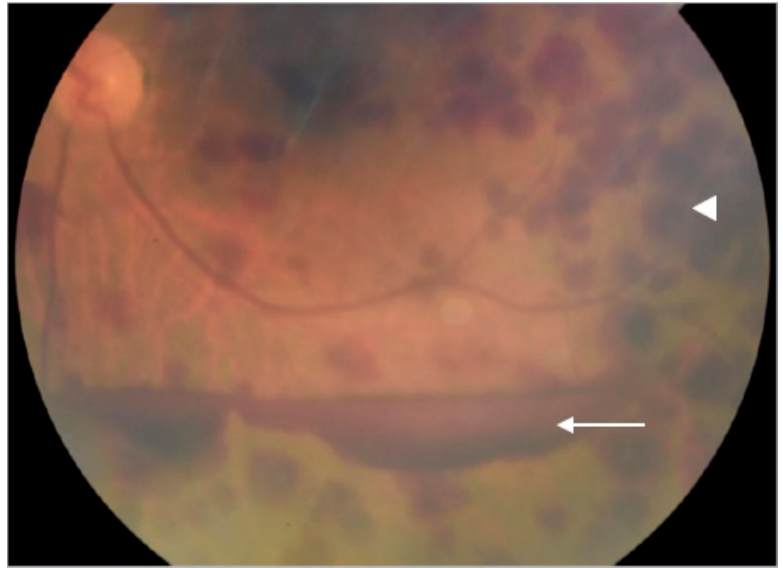
Figure 2. Fundus photography of the left eye showing several intraretinal hemorrhages (white ar- rowhead) and subhyaloid hemorrhages (white arrow) in the posterior pole and mid-peripheral ret- ina.